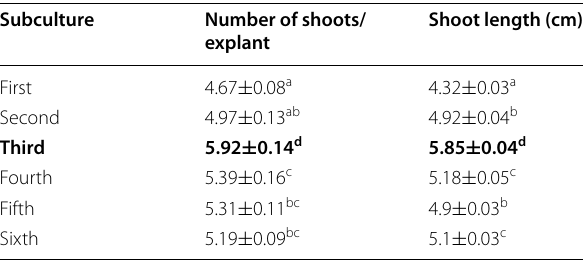
Table 3 Effect of repeated subcultures of microshoots on full- strength Murashige and Skoog medium supplemented with 1.5 mg L -1 6-benzylaminopurine, Indole-3-butyric acid at 0.5 mg L -1 , and α-naphthaleneacetic acid at 0.1 mg L -1 on shoot proliferation of Artocarpus heterophyllus